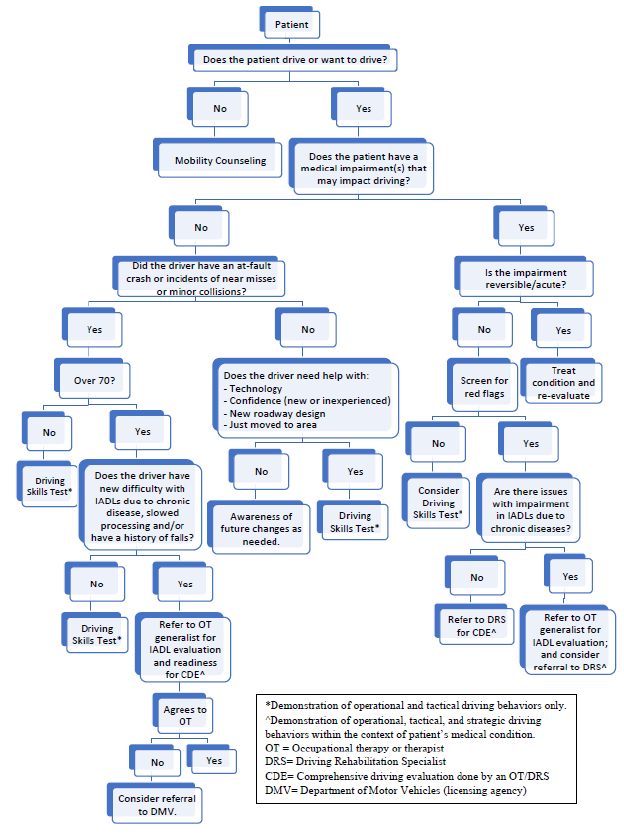
Figure 1. Algorithm to use to make appropriate choice of driving services for older adults when there is a question about their driving safety.